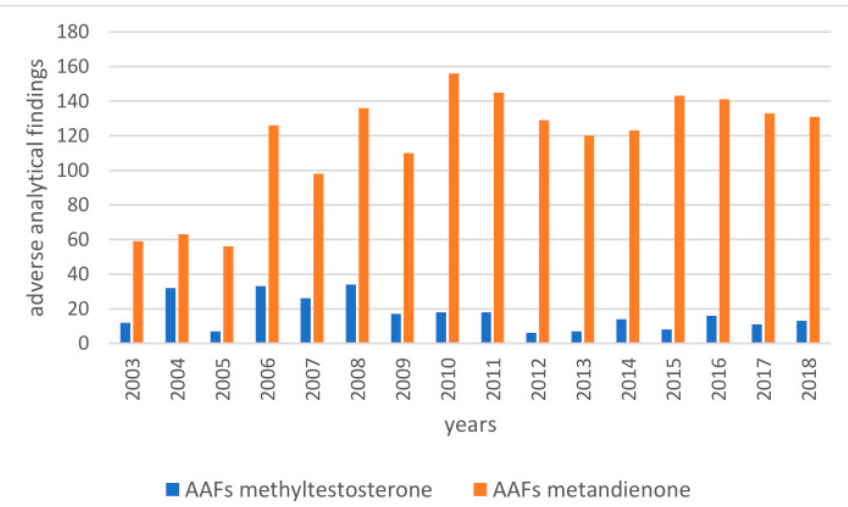
Figure 1. Adverse analytical findings of methyltestosterone and metandienone between 2003 and 2018, according to [4] .